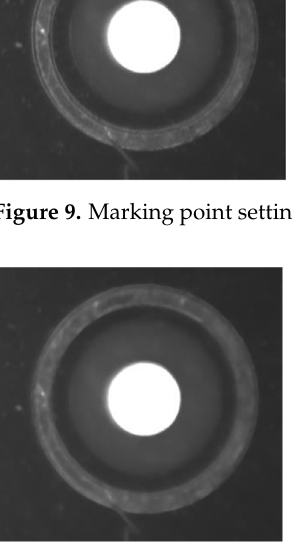
Figure 10. Median Filtering.